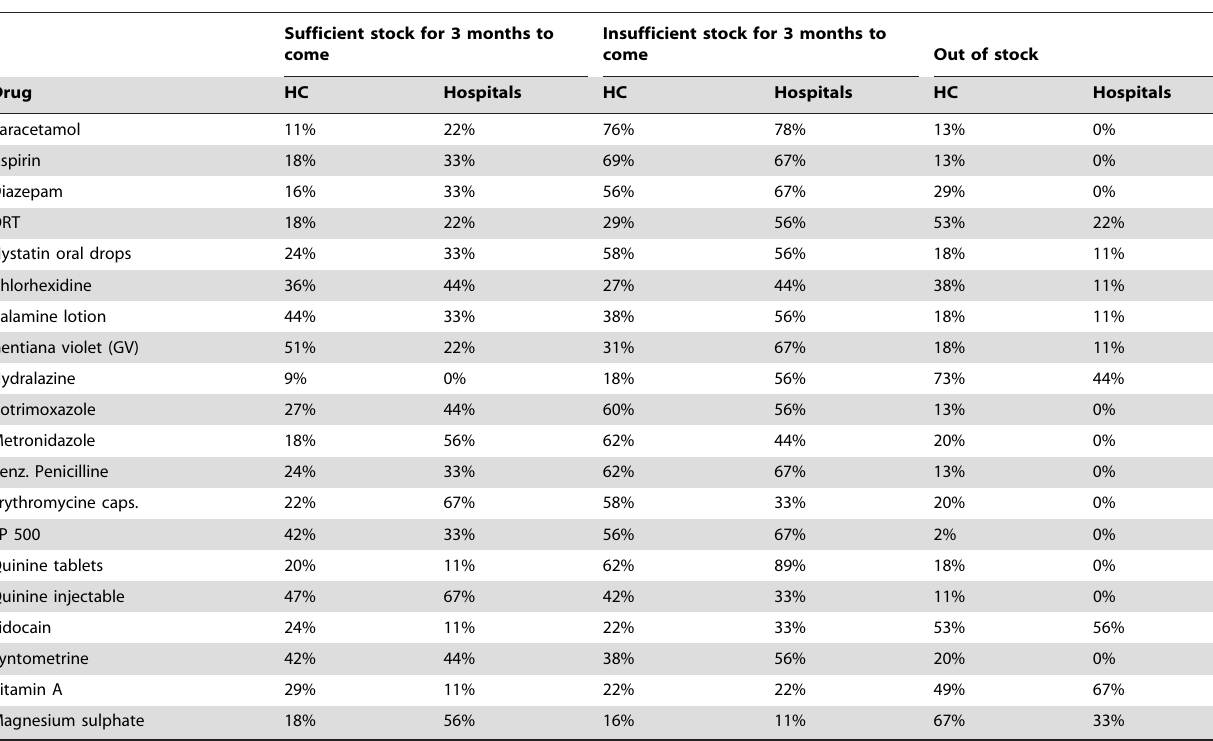
Table 2. Percent of health centres (HC, n =45) or hospitals (n=9) which keep key drugs sufficient, insufficient or not at all in stock at the time of the survey (‘‘sufficient’’ defined as the quantity deemed necessary by the pharmacist/facility manager to treat the average caseload that required this drug during the forthcoming 3 months; differences between HC and hospitals not statistically significant).